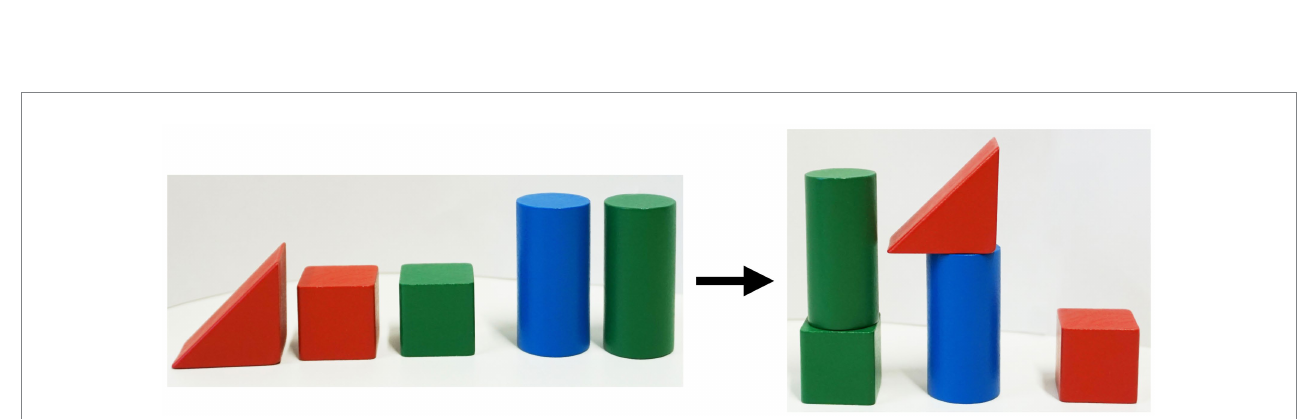
FIGURE 4 Construction test: The building blocks had to be arranged according to a particular rule or a combination of rules.